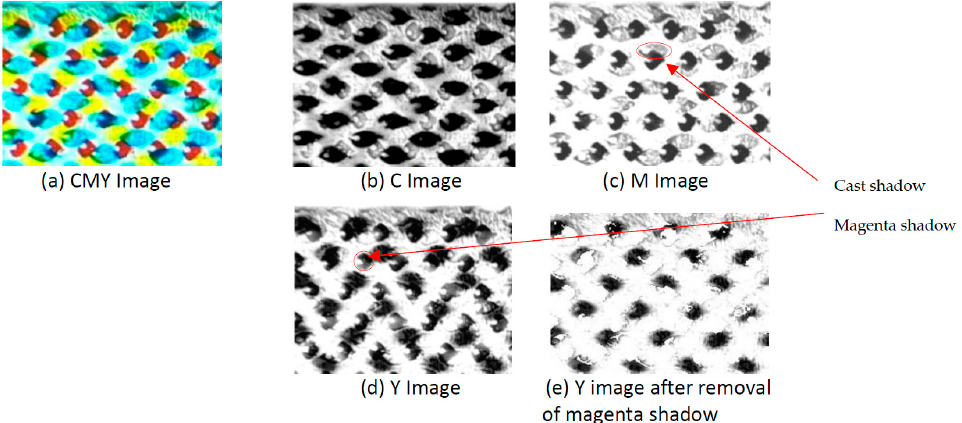
Figure 4. ( a ) Example of halftone misregistration (of offset along X and Y axis) for a CMY image with 20% of ink coverage for each channel. ( b ) Even if the magenta dots are perceptible in the cyan image, there is enough contrast between the cyan dots and the background to segment cyan dots. ( c ) Even if the cyan dots are perceptible in the magenta image, there is enough contrast between the magenta dots and the background to segment magenta dots. ( d ) Magenta dots cannot be dissociated from the yellow dots in the yellow image. ( e ) Magenta dots segmented in the magenta image are removed from the yellow image in order to properly segment yellow dots.